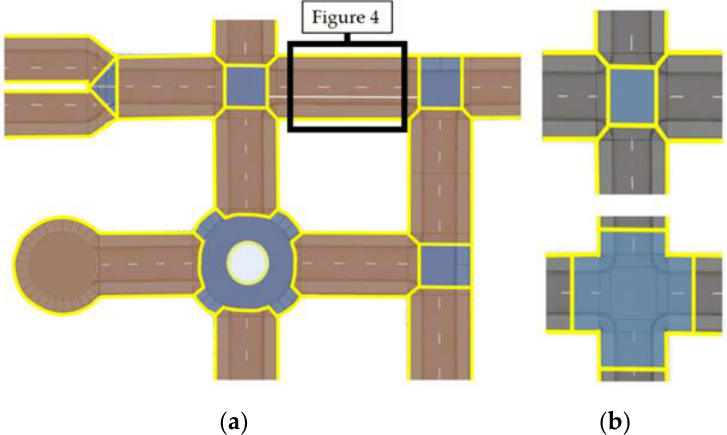
Figure 3. ( a ) Street network segmentation into Sections (orange) and Intersections (blue); ( b ) Different possibilities to define Intersection areas.